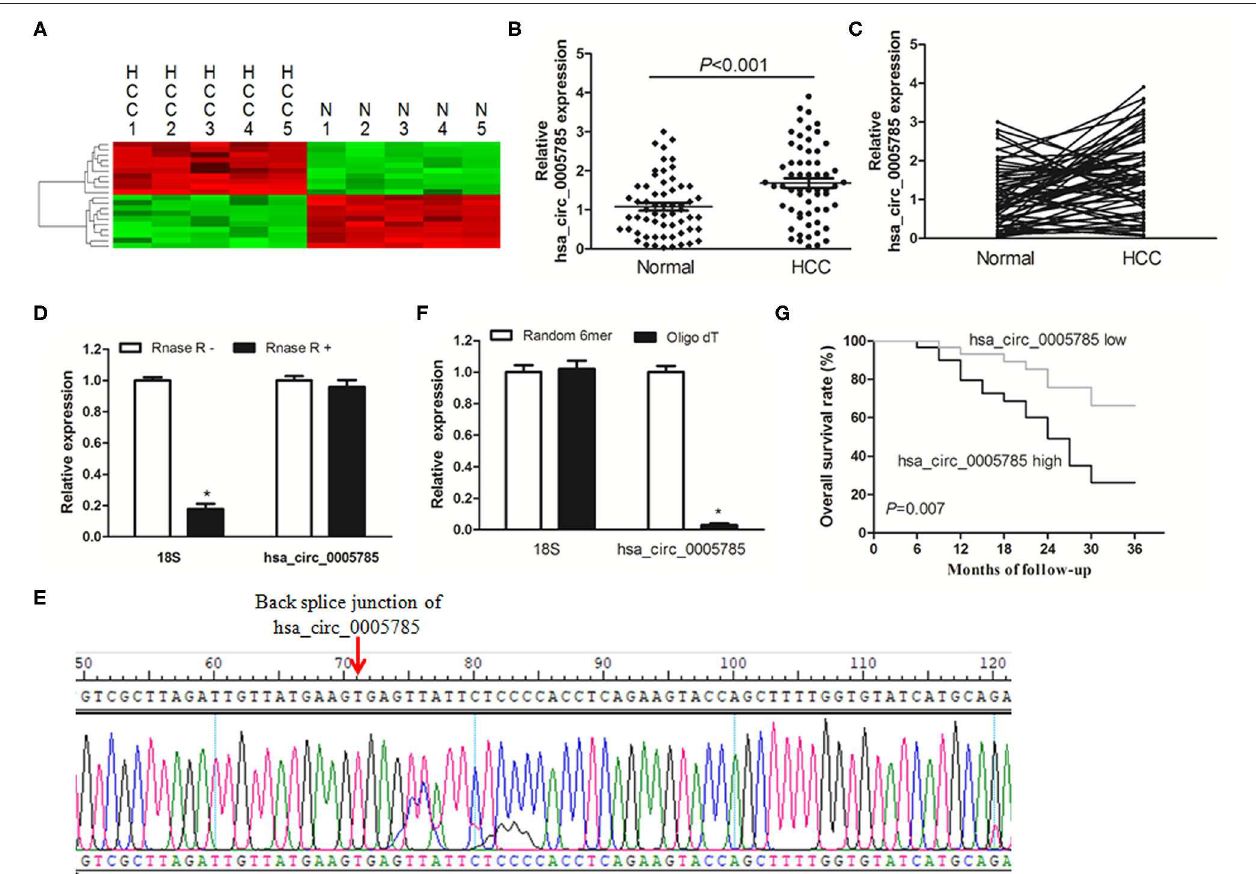
FIGURE 1 | The relative expression of hsa_circ_0005785 in HCC tissues. (A) Heat map analysis of the top 10 obviously dysregulated circRNAs which resulted from microarray assays (5 HCC tissues vs. 5 paired normal tissues). (B,C) qRT-PCR detection of hsa_circ_0005785 expression in 60 HCC tissues and paired normal tissues. (D) Total RNA of HCC tissue was pretreated or not pretreated with RNase R; hsa_circ_0005785 and 18S rRNA levels were detected by qRT-PCR. (E) The qRT-PCR product of hsa_circ_0005785 was verified by Sanger sequencing. (F) The cDNA of hsa_circ_0005785 and 18S rRNA was reverse transcribed with random 6-mer or oligo dT primers and then measured by qRT-PCR. (G) The Kaplan–Meier curve analyzed the prognosis of HCC